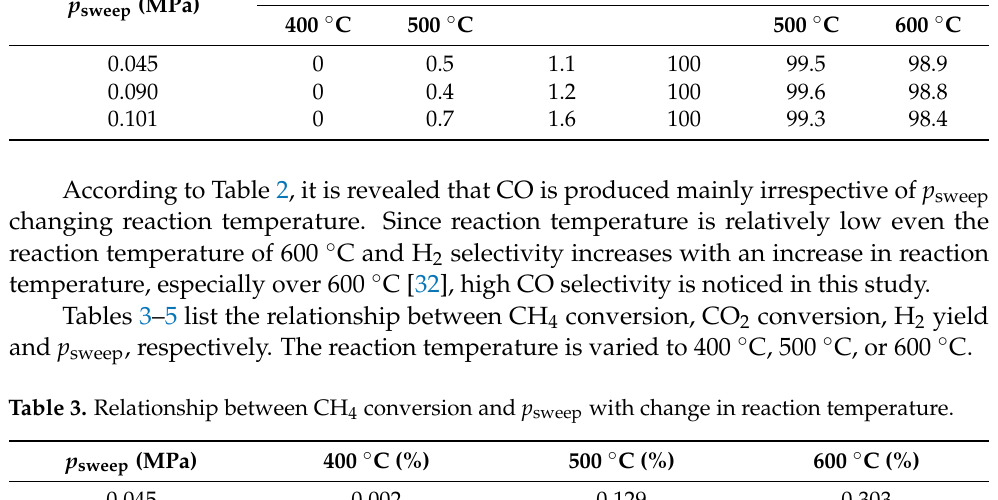
Table 2. Relationship between H 2 , CO selectivity and p sweep with change in reaction temperature. p sweep (MPa)